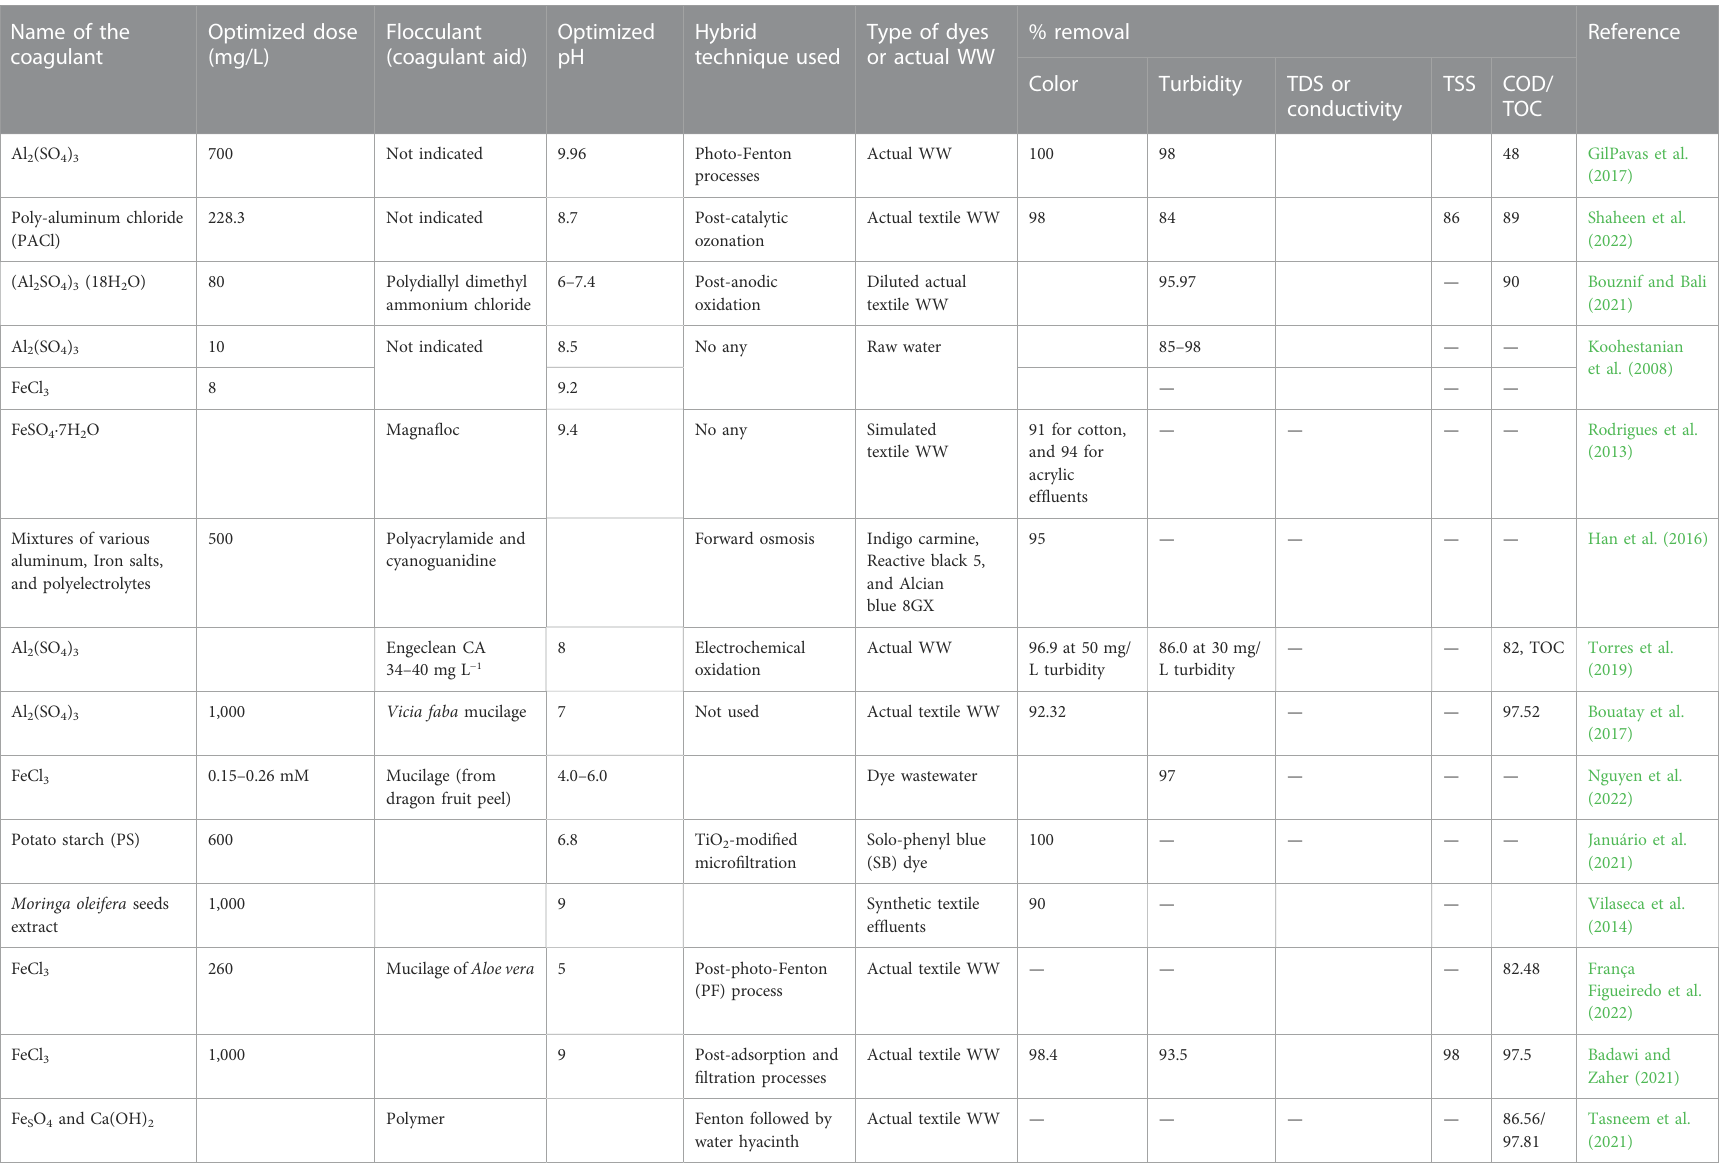
TABLE 2 Summary of the effectiveness of different coagulants studied for colloids and color removal in textile